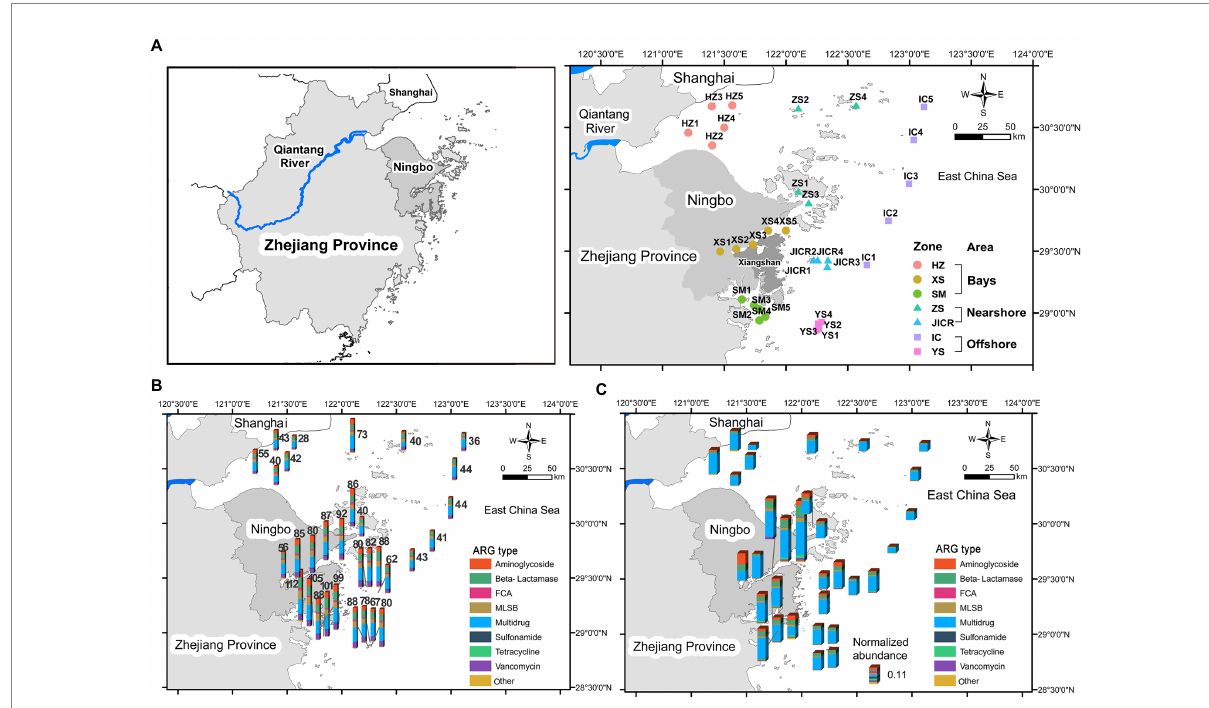
FIGURE 1 The map of sampling stations across the coastal northern Zhejiang, in the East China Sea (A) . Histogram maps showing the spatial distribution of richness (B) and normalized abundance (C) of antibiotic resistance genes (ARGs) across the study region. ARGs were classified based on the type of antibiotics that they confer resistance to. HZ, Hangzhou Bay; XS, Xiangshan Bay; SM, Sanmen Bay; ZS, Zhoushan Islands; JICR, Jiushan Islands Conservation and Reservation; IC, the Eastern Boundary of the Island-Chain; YS, Yushan Islands